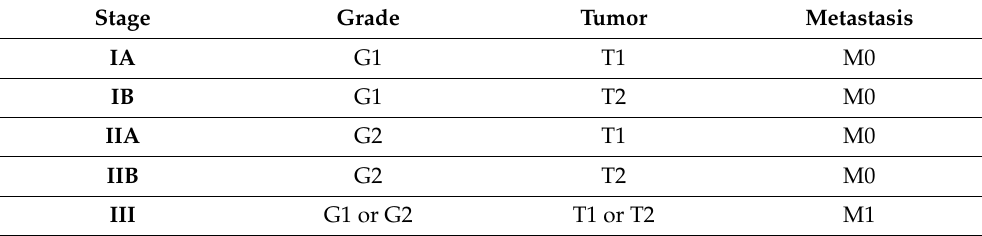
Table 1. MSTS (Musculoskeletal Tumor Society) staging system for osteosarcoma. Each stage is charac- terized by a grade (low grade = G1; high grade = G2), the tumor extension (T1 = intra-compartmental; T2 = extra-compartmental) and presence of metastasis (M0 = no metastasis; M1 = presence of metastasis).